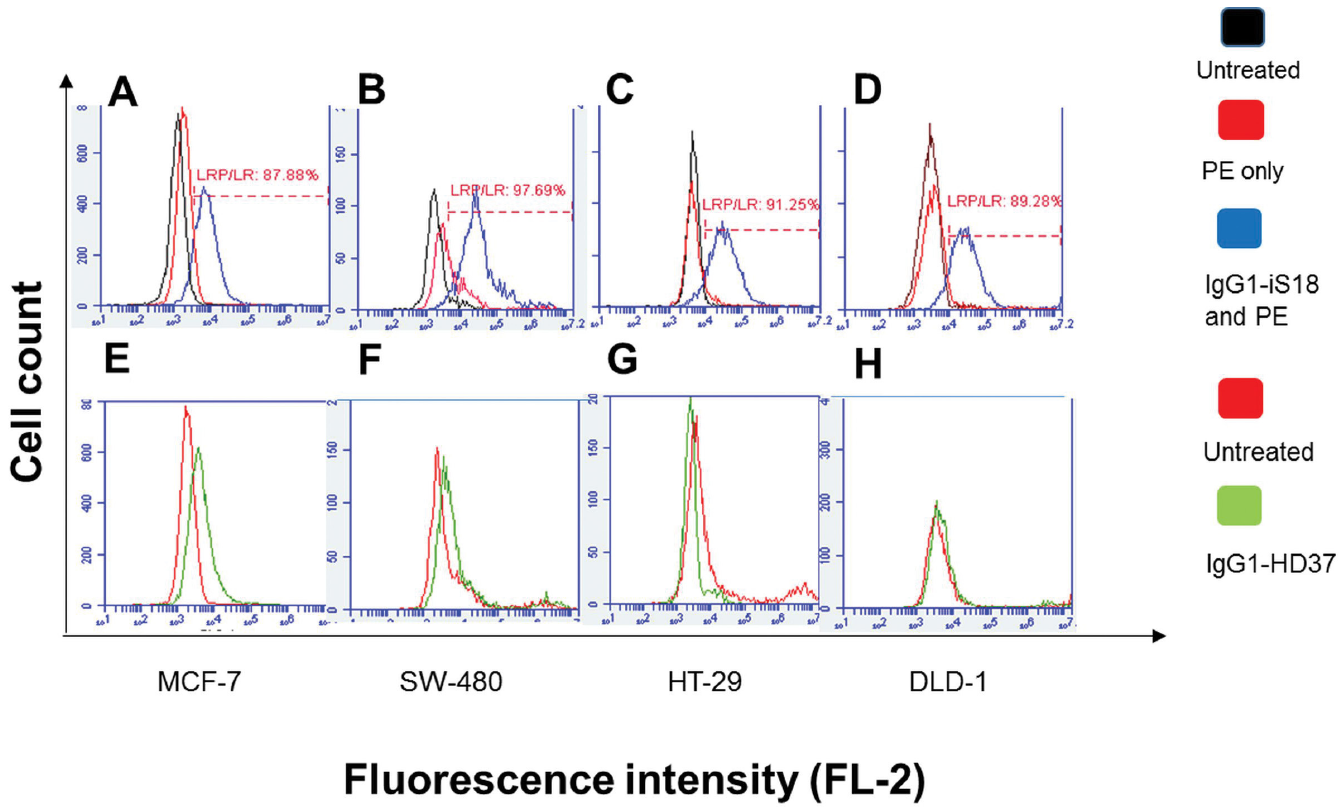
Figure 2. Detection of 37 kDa/67 kDa LRP/LR levels on the surfaces of tumorigenic cell lines. Cells were treated with IgG1-iS18 and IgG1-HD37 (control antibody). (A and E) represent MCF-7, (B and F) represent SW-480, (C and G) represent HT-29, and (D and H) represent DLD-1. In graphs (A, B, C and D) the black peak represents untreated cells, the red peak indicates cells labeled with goat antihuman phycoerythrin–coupled secondary antibody only and the blue peak represents cells labeled with anti-LRP–specific antibody IgG1-iS18 together with secondary antibody, both at a concentration of 30 μg/mL. In graphs (E, F, G and H) the red peak indicates un- treated control to show no nonspecific binding from the secondary antibody; the green peak represents control antibody IgG1-HD37 together with the secondary antibody. These data represent experiments performed in triplicate using different cell cultures, with 20,000 cells counted per